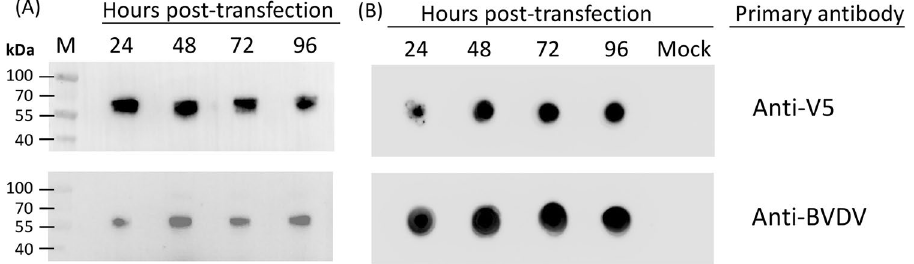
Figure 2. Evaluation of truncated E2 glycoprotein expression. ( A ) Western blot analyses of transfected cell extracts. Samples of cellular extracts were prepared and analyzed (12% SDS–PAGE) prior to the transfer, as described in methods. ( B ) Immuno-dot blot analyses of the cell media. Tissue culture media from BHK-21 cells transfected with truncated E2 glycoprotein at the indicated time points. Membranes were probed with the mouse anti-V5 monoclonal antibody (1:8000) or mouse anti-BVDV antiserum (1:4000) as primary antibody. Lane M: prestained protein marker, lane mock: untransfected BHK-21